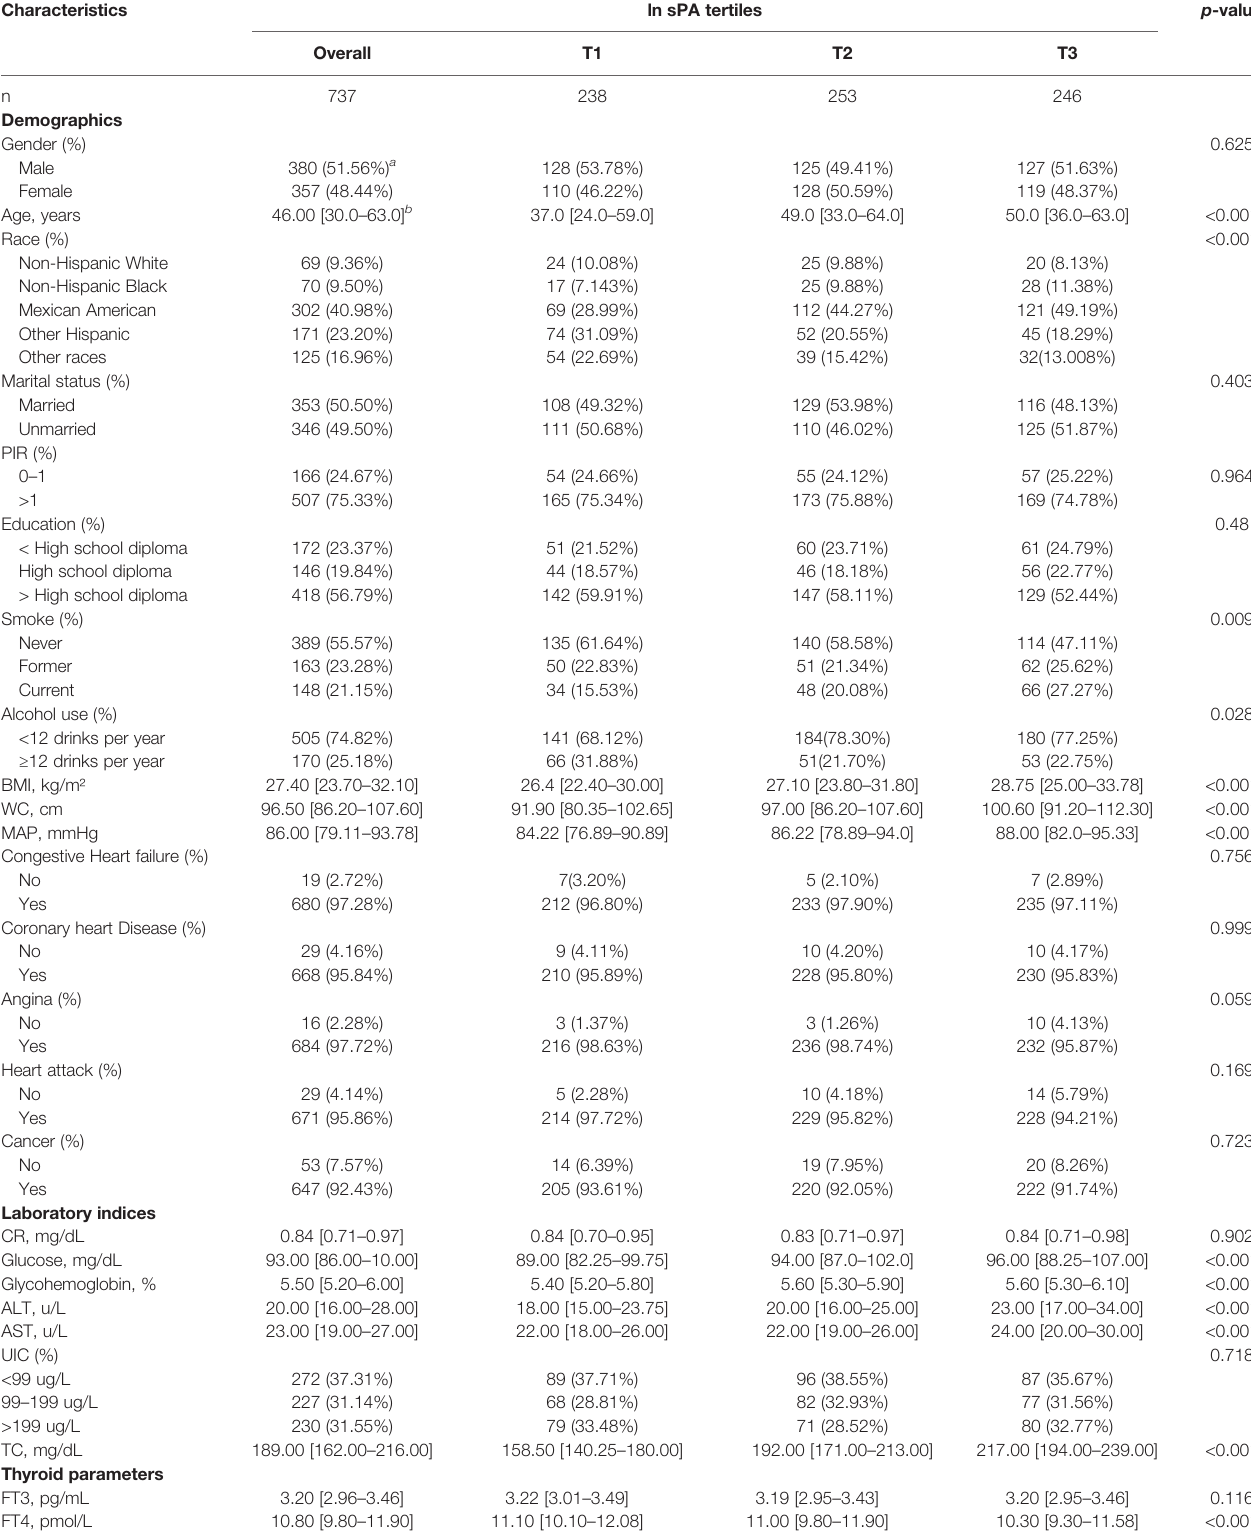
TABLE 1 | Baseline characteristics of the NHANES (2011 – 2012) study population in ln sPA tertiles.